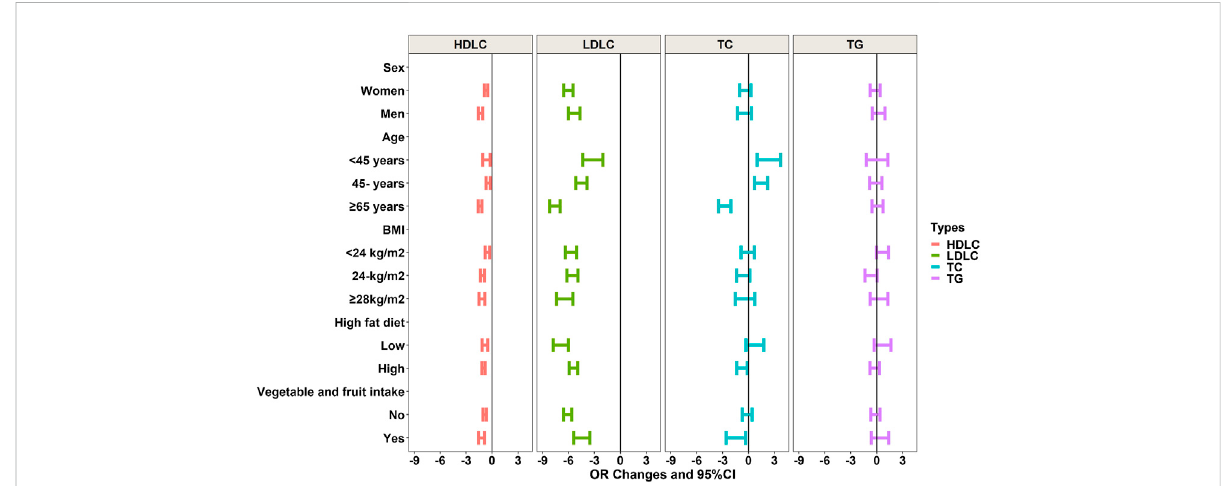
FIGURE 2 Interactions of age, sex, BMI, and lifestyle on relationships between PM 2.5 and blood lipids.